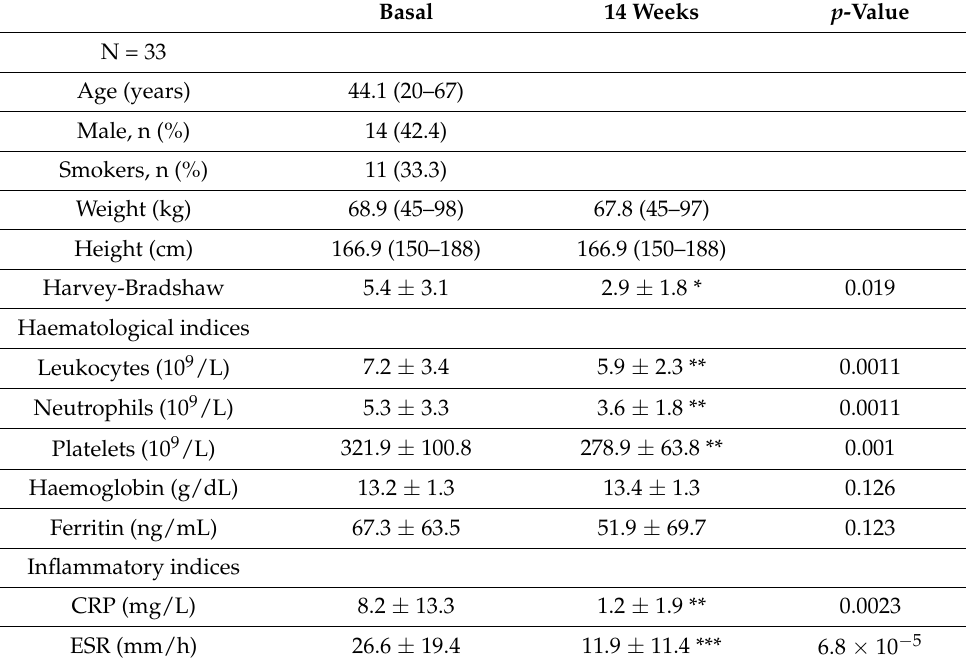
Figure 6. Correlation between serum levels of AIF-1 and CRP in patients with Crohn’s disease. The red dots represent patients with HB ≥ 5 and the blue dots those with HB ≤ 4. The regions that were compared to obtain the OR were high risk (CRP > 5 mg/L or AIF-1 > 200 pg/mL or both conditions at the same time) and low risk (CRP ≤ 5 mg/L and AIF-1 ≤ 200 pg/mL) for active (HB ≥ 5) or inactive (HB ≤ 4) CD. Table 2. Hematological indices and biochemical parameters obtained from patients with CD under baseline conditions and after 14 weeks of anti-TNF α treatment. * p < 0.05; ** p < 0.01; *** p < 0.001. Basal 14 Weeks p